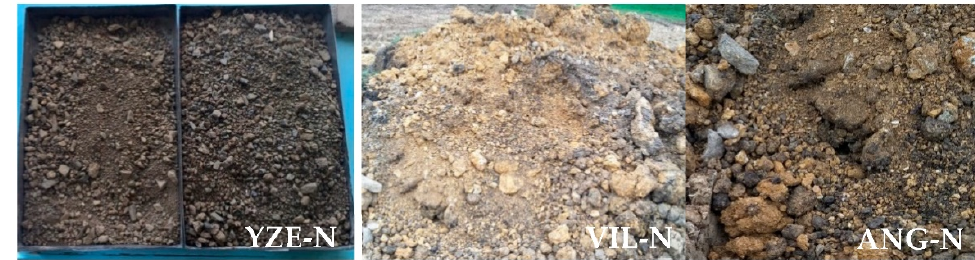
Figure 9. Visuals of all three natural trench cuttings. Table 4. Geotechnical properties testing standards.